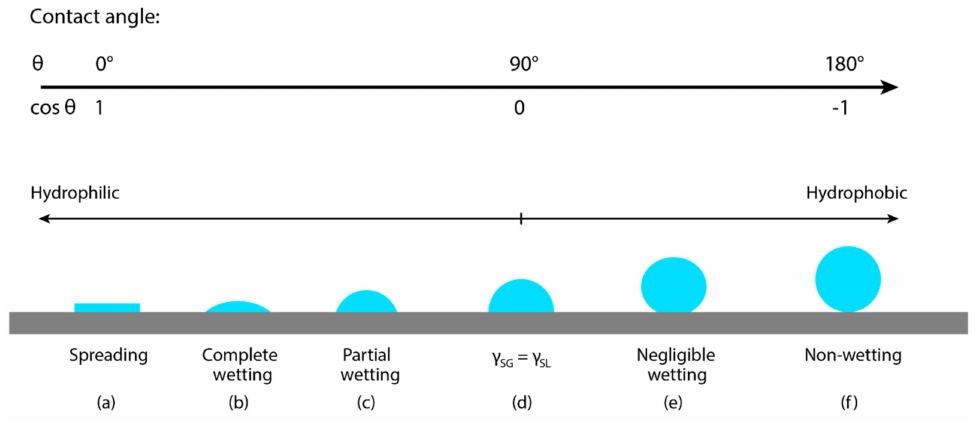
Figure 3. Representation of the various scenarios which can occur when a droplet is deposited onto a dry solid surface, illustrating the possible wetting states.